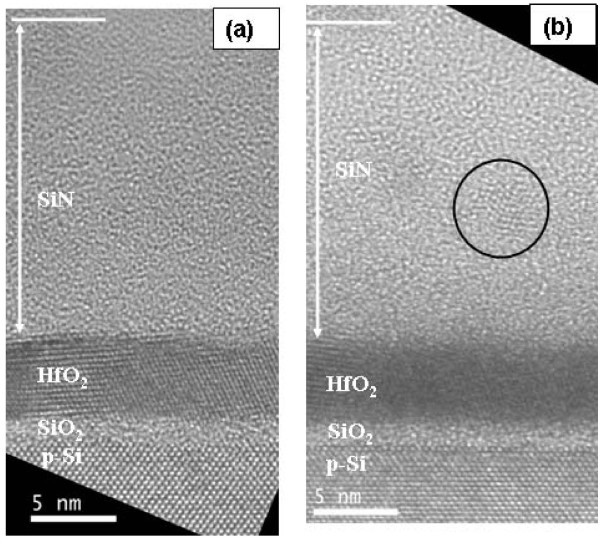
Cross-sectional HREM images of Ge+-implanted SiN/HfO2/SiO2 stack layers. Cross-sectional HREM images of Ge+-implanted SiN layers with HfO2/SiO2 stack tunnel dielectrics at two different energies (a) 3 keV, and (b) 5 kev, with dose of 1.5 × 1016 cm-2, followed by a post-implantation thermal annealing at 800°C in N2. In the images, the surface of SiN layer is indicated by a white line